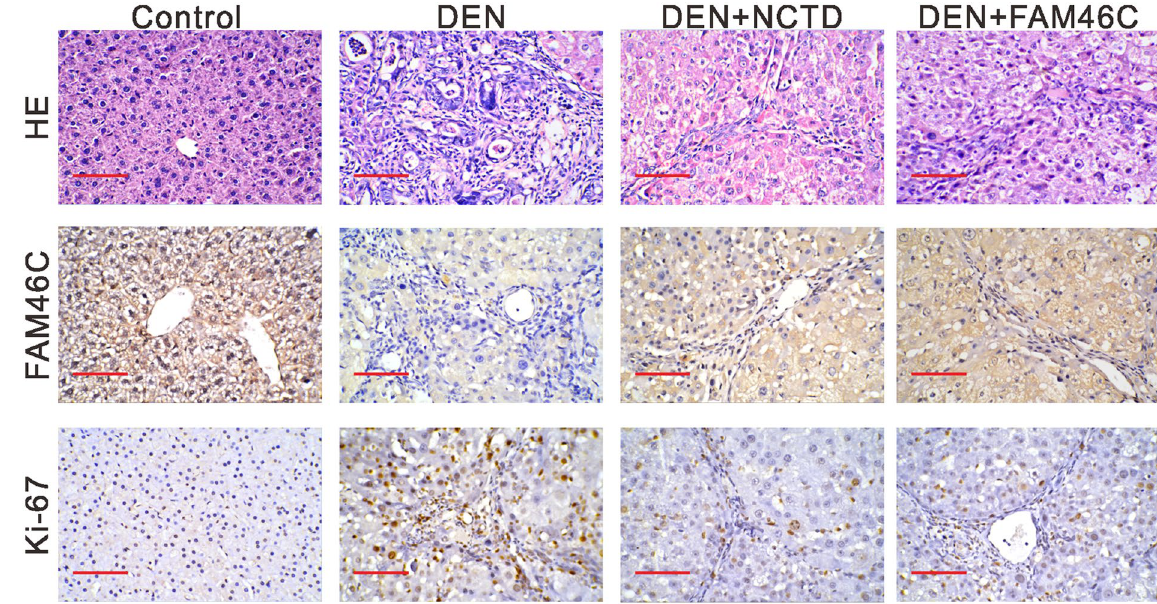
Figure 3. Pathological changes of liver in 4 groups mice (n = 8 per group). Light microscopy of HE staining, and IHC staining of FAM46C and Ki-67 (200x magnification) in Control group, DEN group, DEN + NCTD group and DEN + FAM46C